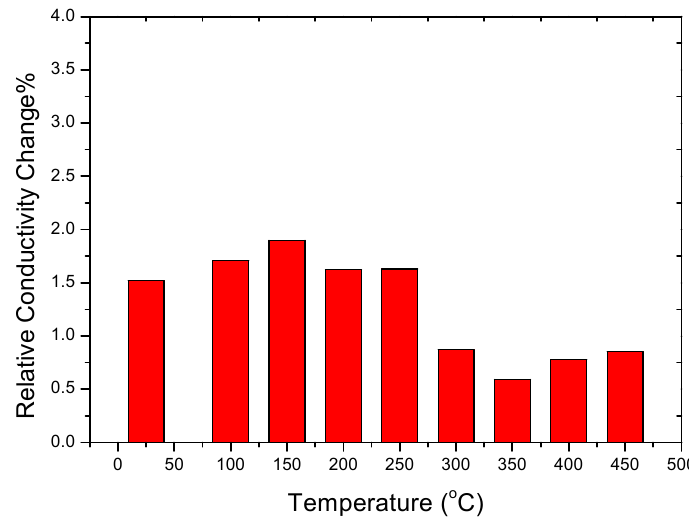
Figure 6. Differences in electrical conductivity in 5383-H116 NAMLT after different heat treatment conditions and sensitization treatment.